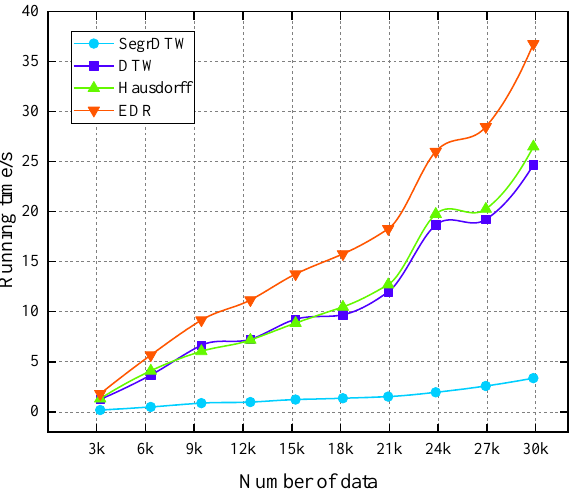
Figure 9. Running efficiency tests on different data volumes.